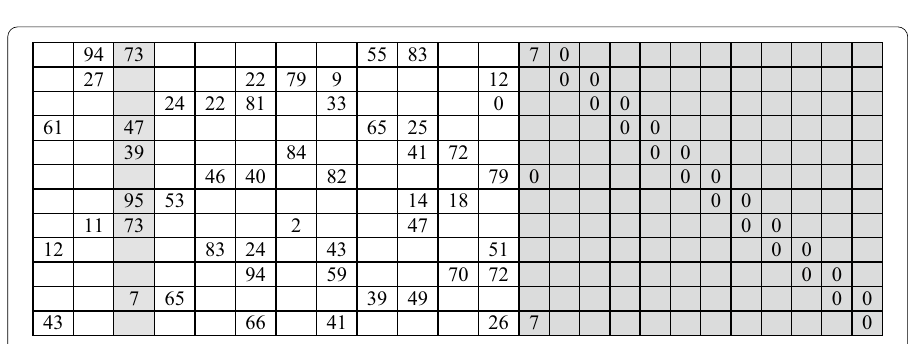
Fig. 2 Base matrix of a 1/2-rate (2304,1152)-QC-LDPC code utilized in IEEE